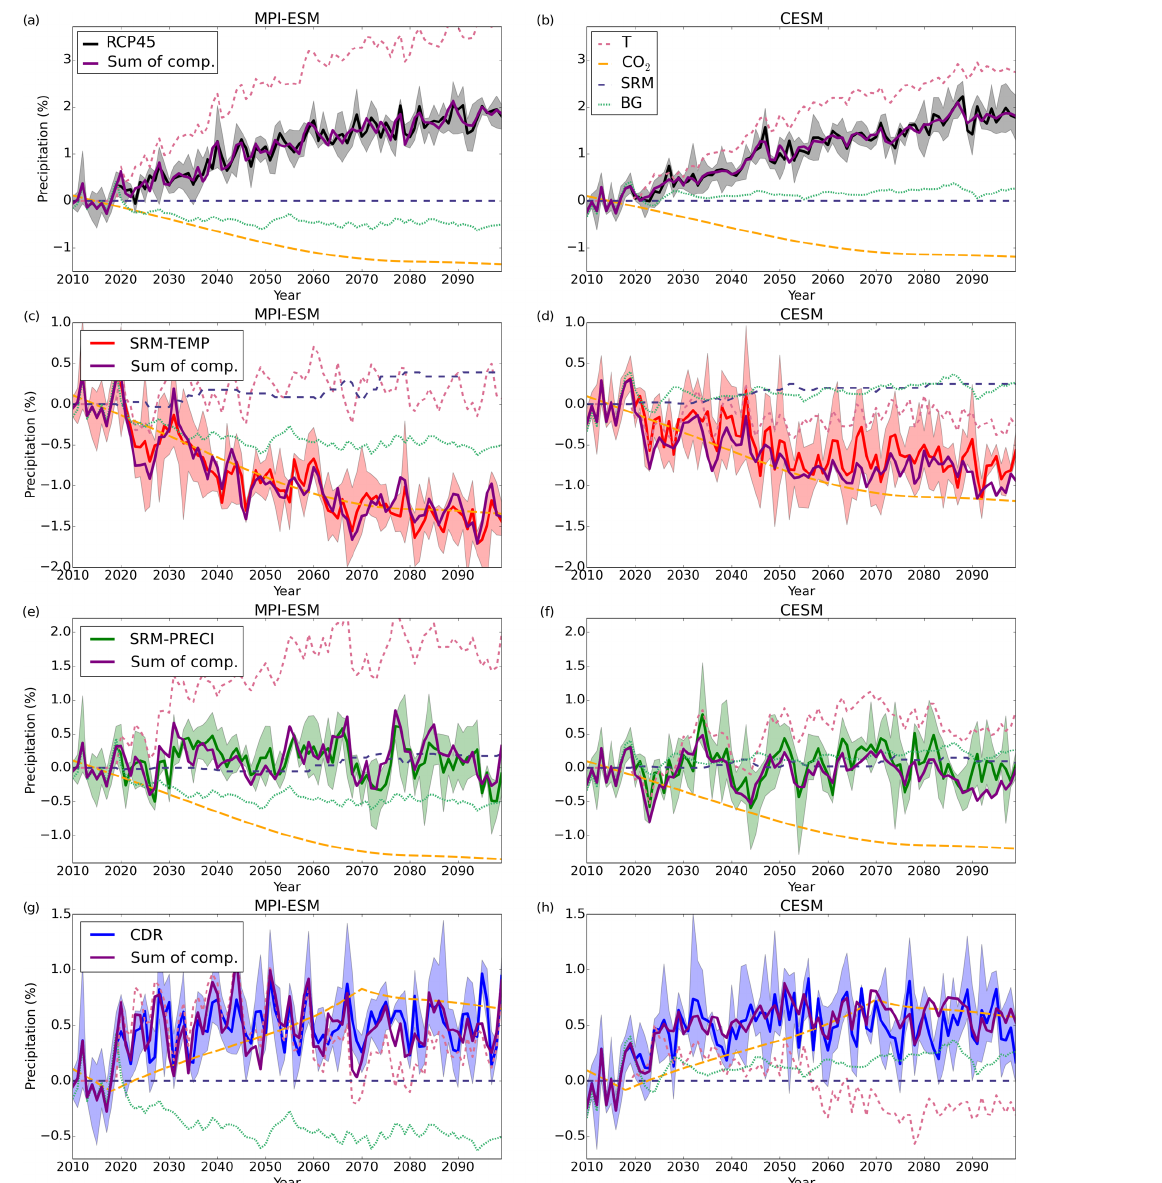
Figure 7. Precipitation components for each of the simulated scenarios. Solid coloured lines with shaded areas have the same meaning as in Fig. 5c and d. Dashed coloured lines indicate the precipitation change caused by individual components (see legend in b ) for each scenario and model. The purple solid line shows the sum of all precipitation components ( T , SRM, CO 2 , and